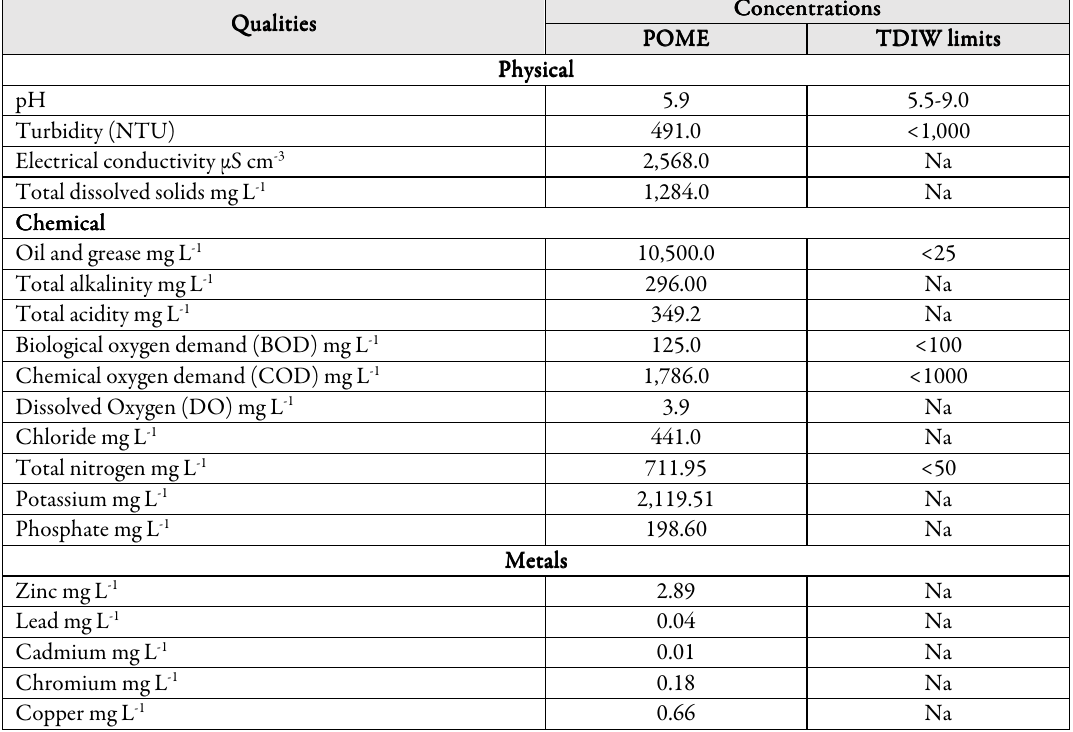
Table 1. Physicochemical properties of